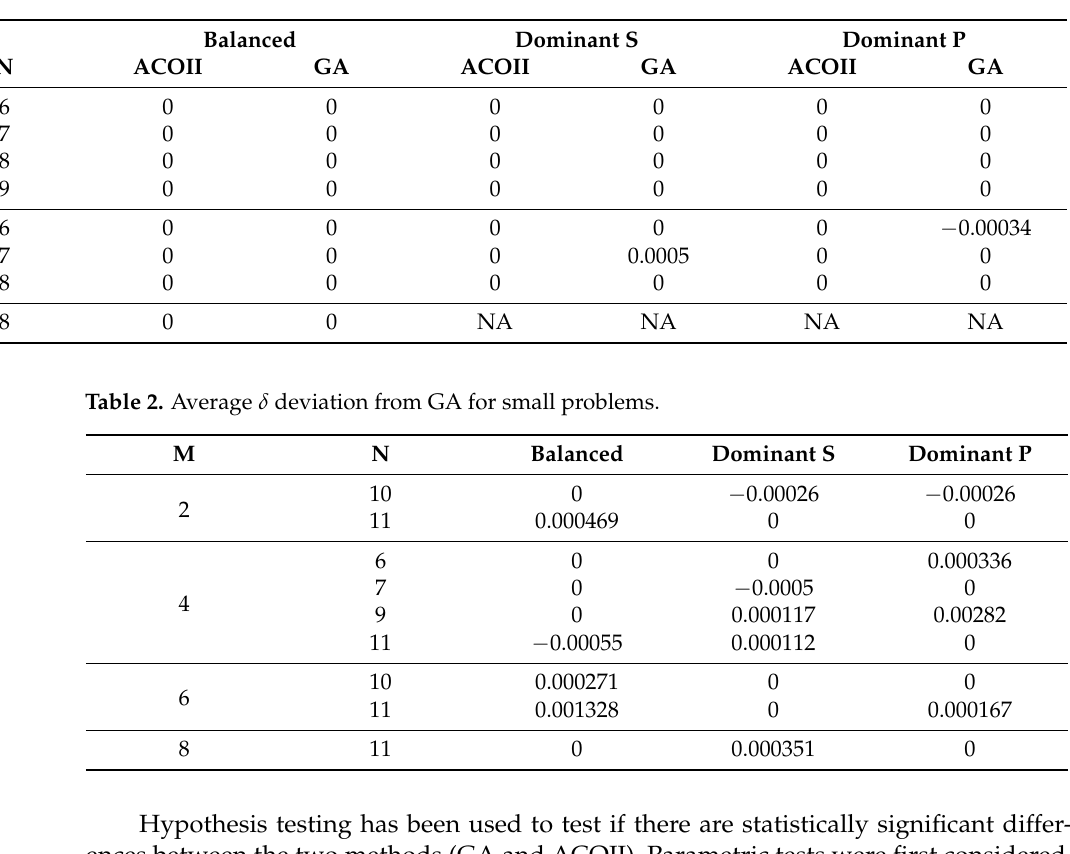
Table 1. Average γ deviation from optimal solutions for small problems.